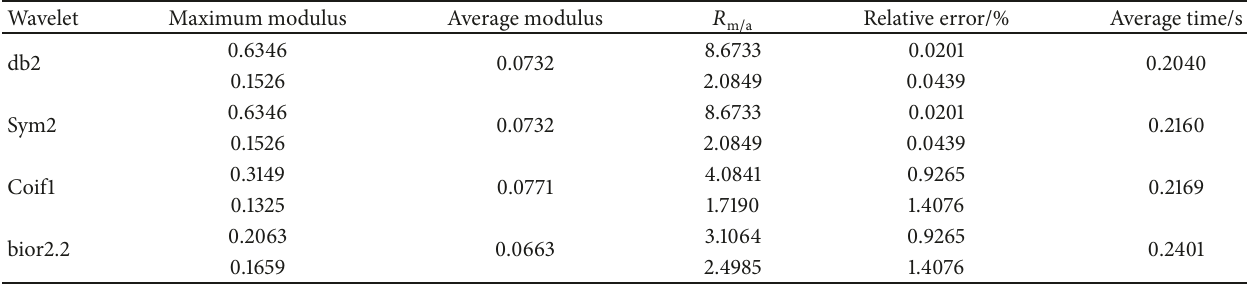
Table 8: Comparison of envelope method with different